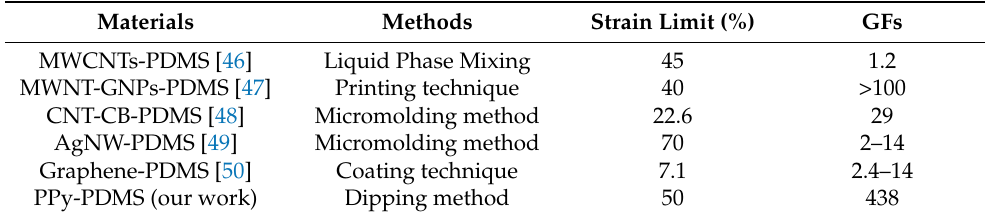
Figure 5. ( a ) GFs (gauge factors) of the multi-layer PPy/PDMS strain sensors fabricated with two different O 2 PT time intervals of 0 (CS) and 30 s. GFs (at a strain of 50 %) of the sensors fabricated with four different O 2 PT time intervals were summarized in an inset table. ( b ) Transient responses of 0 (CS) and 30 s O 2 PT PPy/PDMS strain sensors (when a quasi-step function strain varying from 0 to 1% applied as shown in the bottom-left insets of each transient plot) in terms of normalized resistance and an inset table summarizing the transient response times for the strain sensors fabricated with 60 s and 90 s PT conditions. Table 1. Comparison of previously reported flexible strain sensors based on